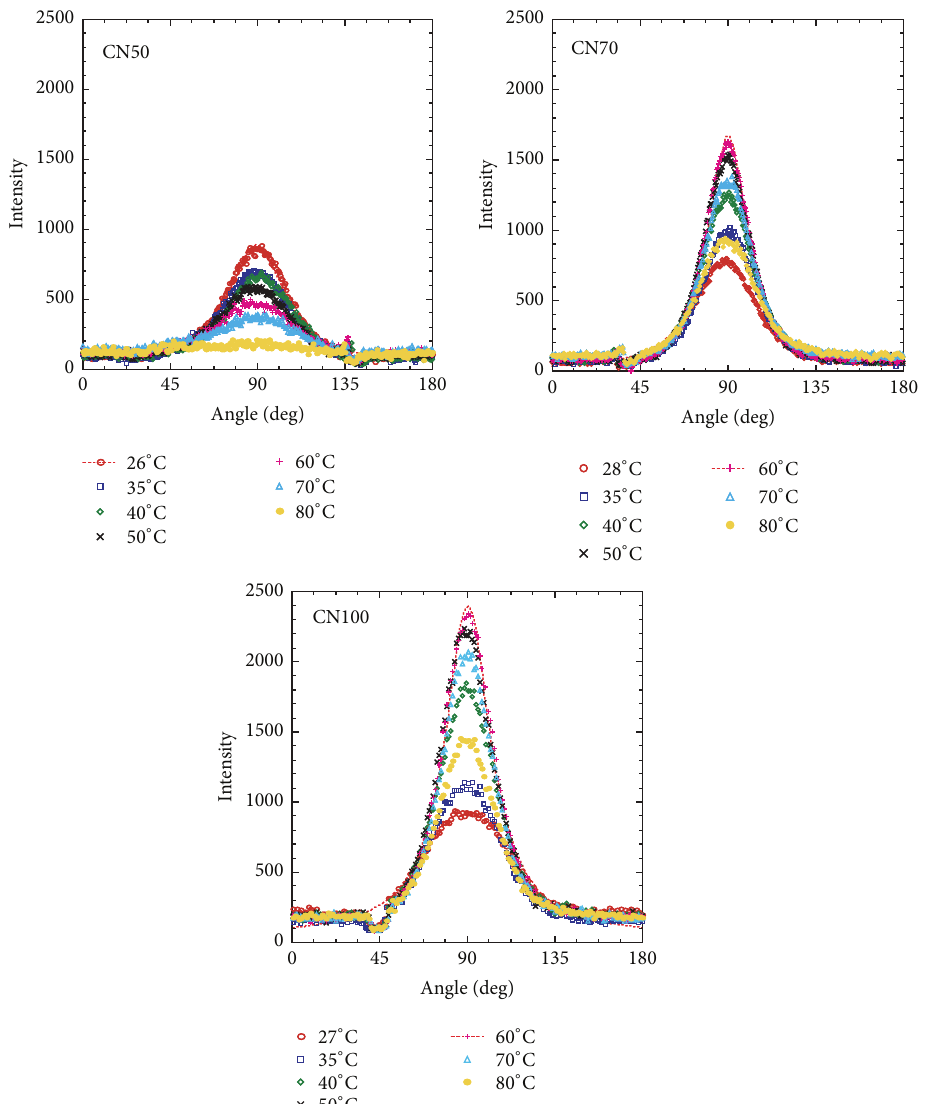
Figure 8: Azimuthal ( 𝛽 in Figure 7) intensity profiles of the small angle peaks at several temperatures for CN50, CN70, and CN100. The intensities are normalized by the background levels due to the polymer backbones. In CN70 and CN100, the peak height (intensity) as well as the peak area are maximum near 𝑇 ∗ = 60 ∘